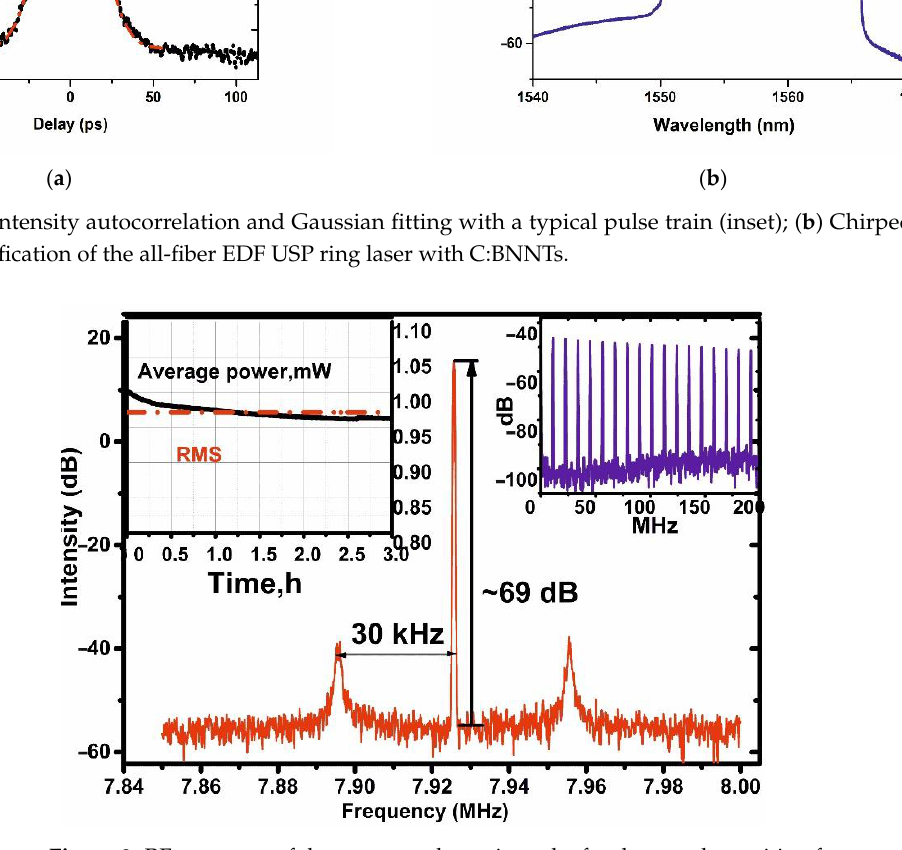
Figure 3. RF spectrum of the output pulse train at the fundamental repetition frequency (the cen- tral peak corresponds to the repetition rate of ~7.925 MHz, RBW = 300 Hz). Inset shows an average output optical power during the measurement and a full scale (up to 200 MHz) RF spectrum of mode-locked pulses (RBW = 3 kHz).